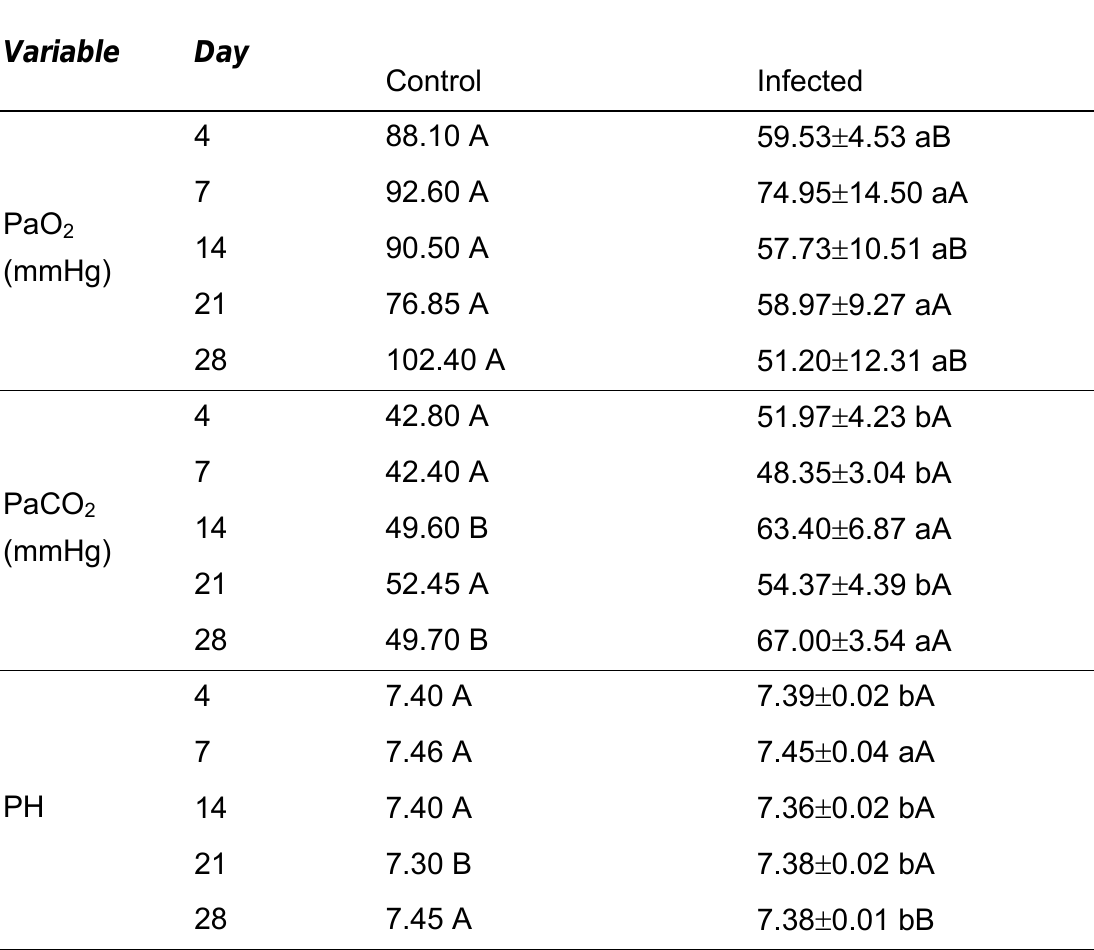
Table 1. Mean arterial oxygen tension, arterial dioxide carbon tension and arterial pH (mean±SD) in hamsters inoculated with Leptospira interrogans Icterohaemorrhagiae and their respective control